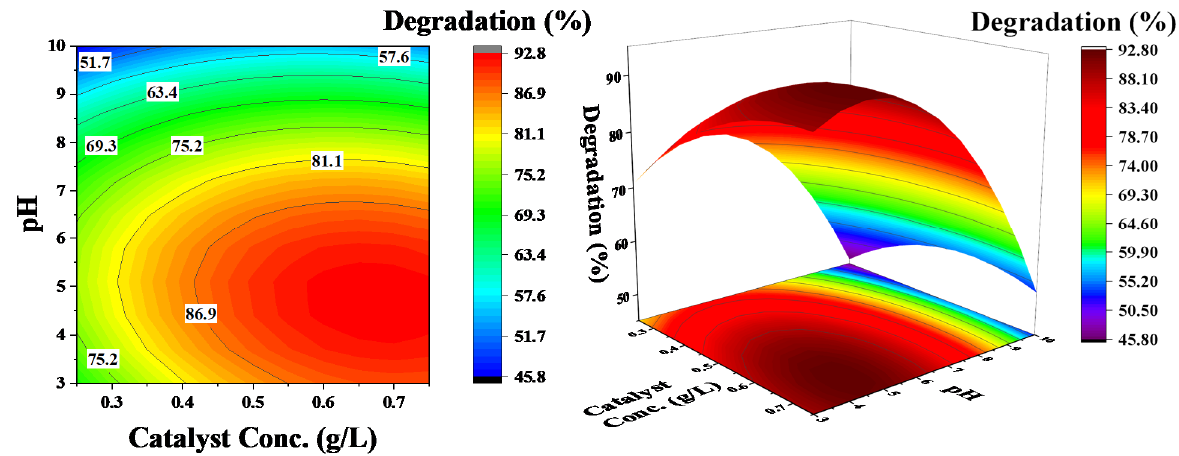
Figure 7. Effect of catalyst concentration and pH on the degradation of phenol: pollutant concentration was kept constant at 60 ppm.